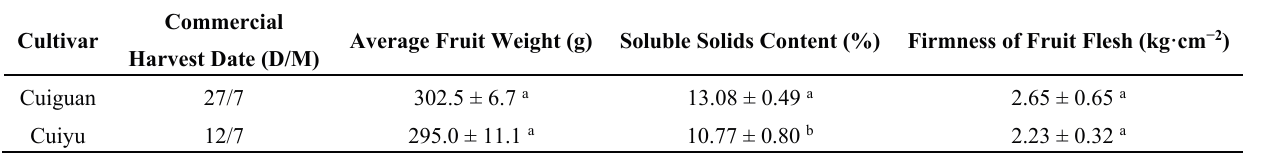
Different letters within each column indicate means that are significantly different ( p ≤ 0.05).